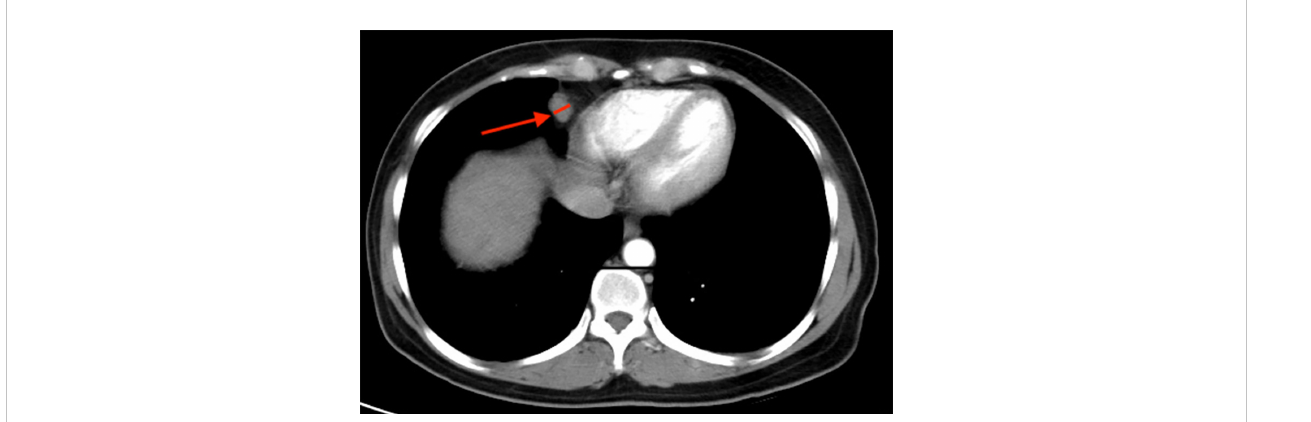
FIGURE 2 Staging CT image showing an example of cardiophrenic lymph node (CPLN) of 9.4 mm in the short axis and located in the anterior right location.